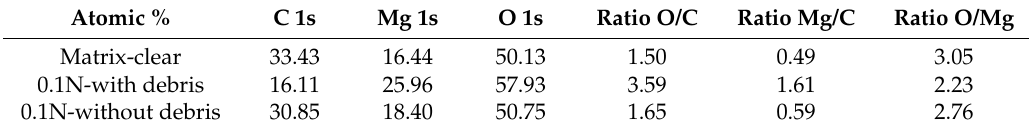
Figure 10. Mg (KLL) Auger spectra for the substrate surfaces of Mg alloy ( a ) 0.1 N after 1000 cycles sliding friction without debris ( b ) initial matrix surface. Table 2. Atomic percentage of the C 1s, Mg 1s, O 1s before and after sliding friction.